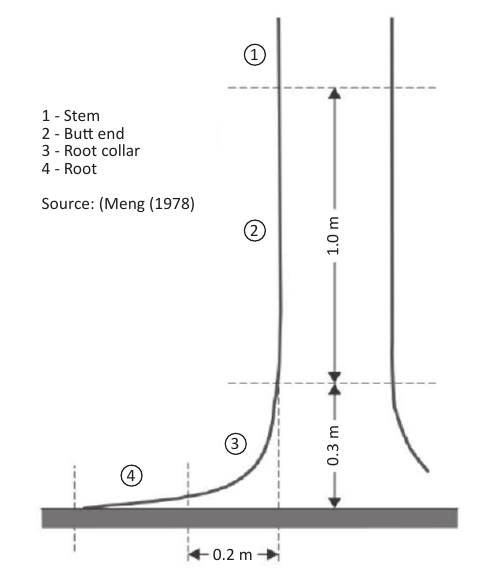
FIgURe 2. Classification of the position of tree damage.